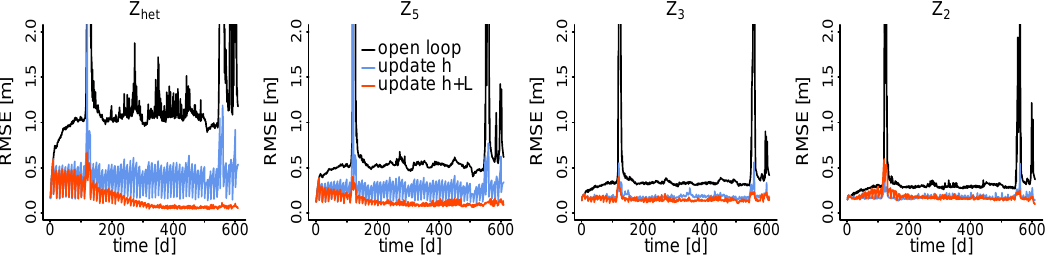
Fig. 5. RMSE h for open-loop simulations, update of hydraulic heads and joint update of hydraulic heads and leakage coefficients (scenario A). Four different ensembles are compared.